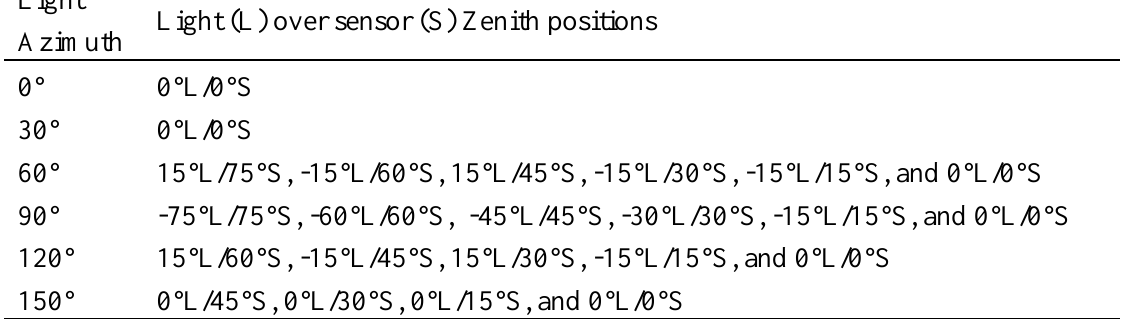
Table 2 . Combination of light source and sensor positions that present lower than expected reflectance values due to shadow-casting on the target. Major signal drop positions exist at 60° and 90° azimuth of the light source and are attributed to construction